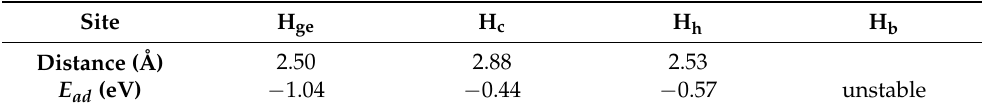
Figure 1. ( a ) Four possible K ion adsorption sites in a 5 × 5 × 1 supercell of g-GeC surface, ( b ) the adsorption energies of K ions on g-GeC as functions of the ratio of K/C in various supercells for both one-surface and two-surface adsorption. Note the green square in ( b ) indicates the two-surface adsorption of K ions on g-GeC (double-layer model). Table 1. The parameters of K adsorption on g-GeC layer calculated in supercell 5 × 5 × 1, including the distance between K and g-GeC layer and corresponding adsorption energy at different absorption